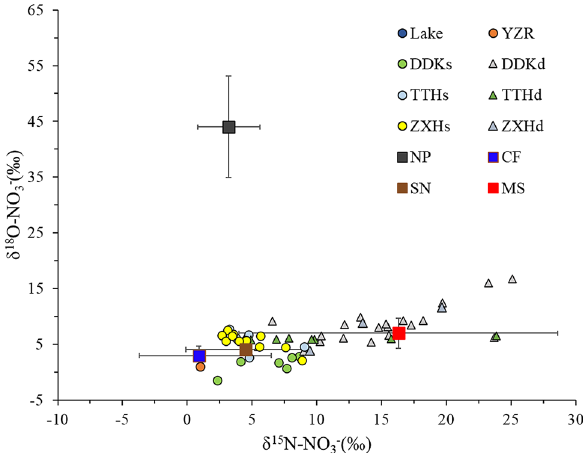
Figure 1. Cross plot of d 15 N and d 18 O values in the water samples of Lake, YZR, DDKs, DDKd, TTHs, TTHd, ZXHs and ZXHd. The ranges of isotopic composition of various sources including nitrogen fertilizer (CF), atmospheric precipitation (NP), soil organic nitrogen (SN), and manure/sewage (MS).